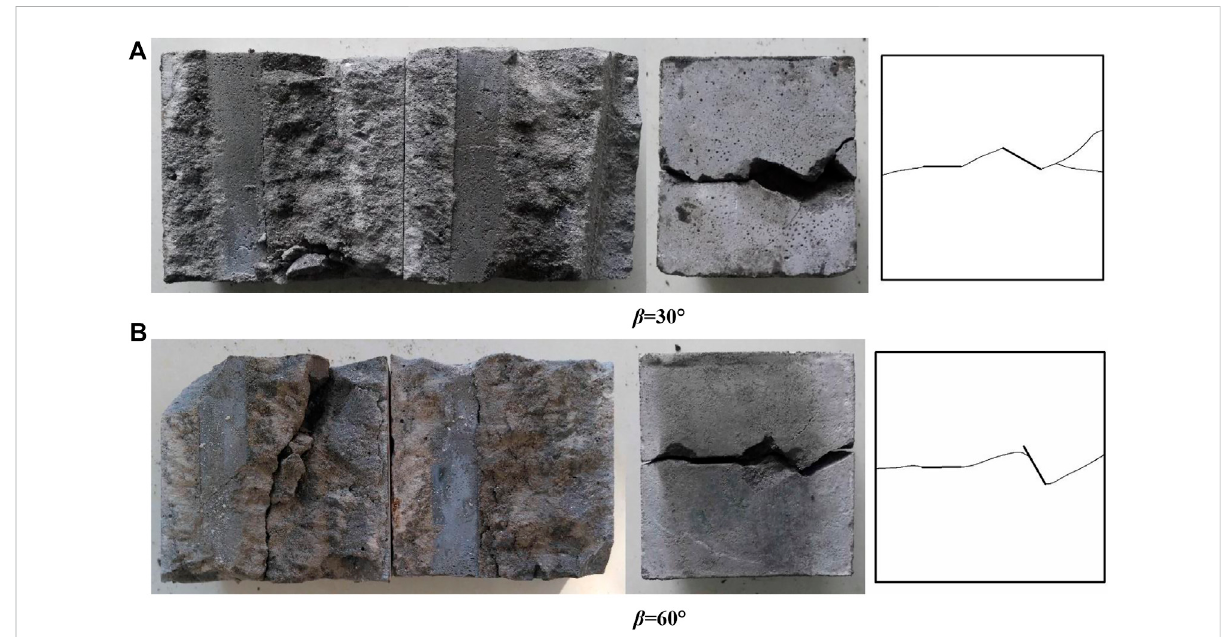
FIGURE 13 Shear failure surface and form of specimens under normal stress of 5 MPa ( α = 180 ° ). (A) β = 30 ° , (B) β = 60 ° .